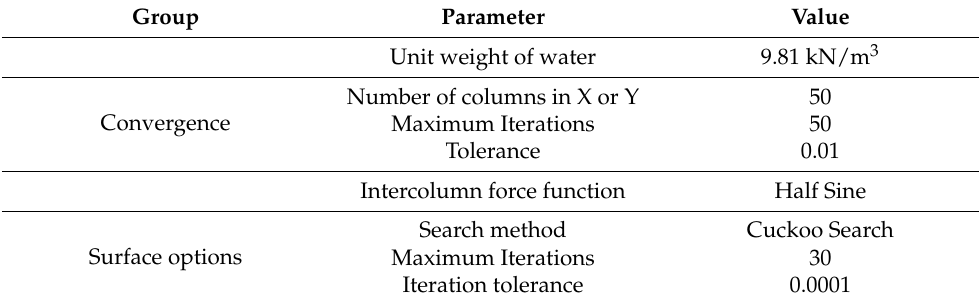
Table 2. Analysis parameters used in the Rocsience Slide3